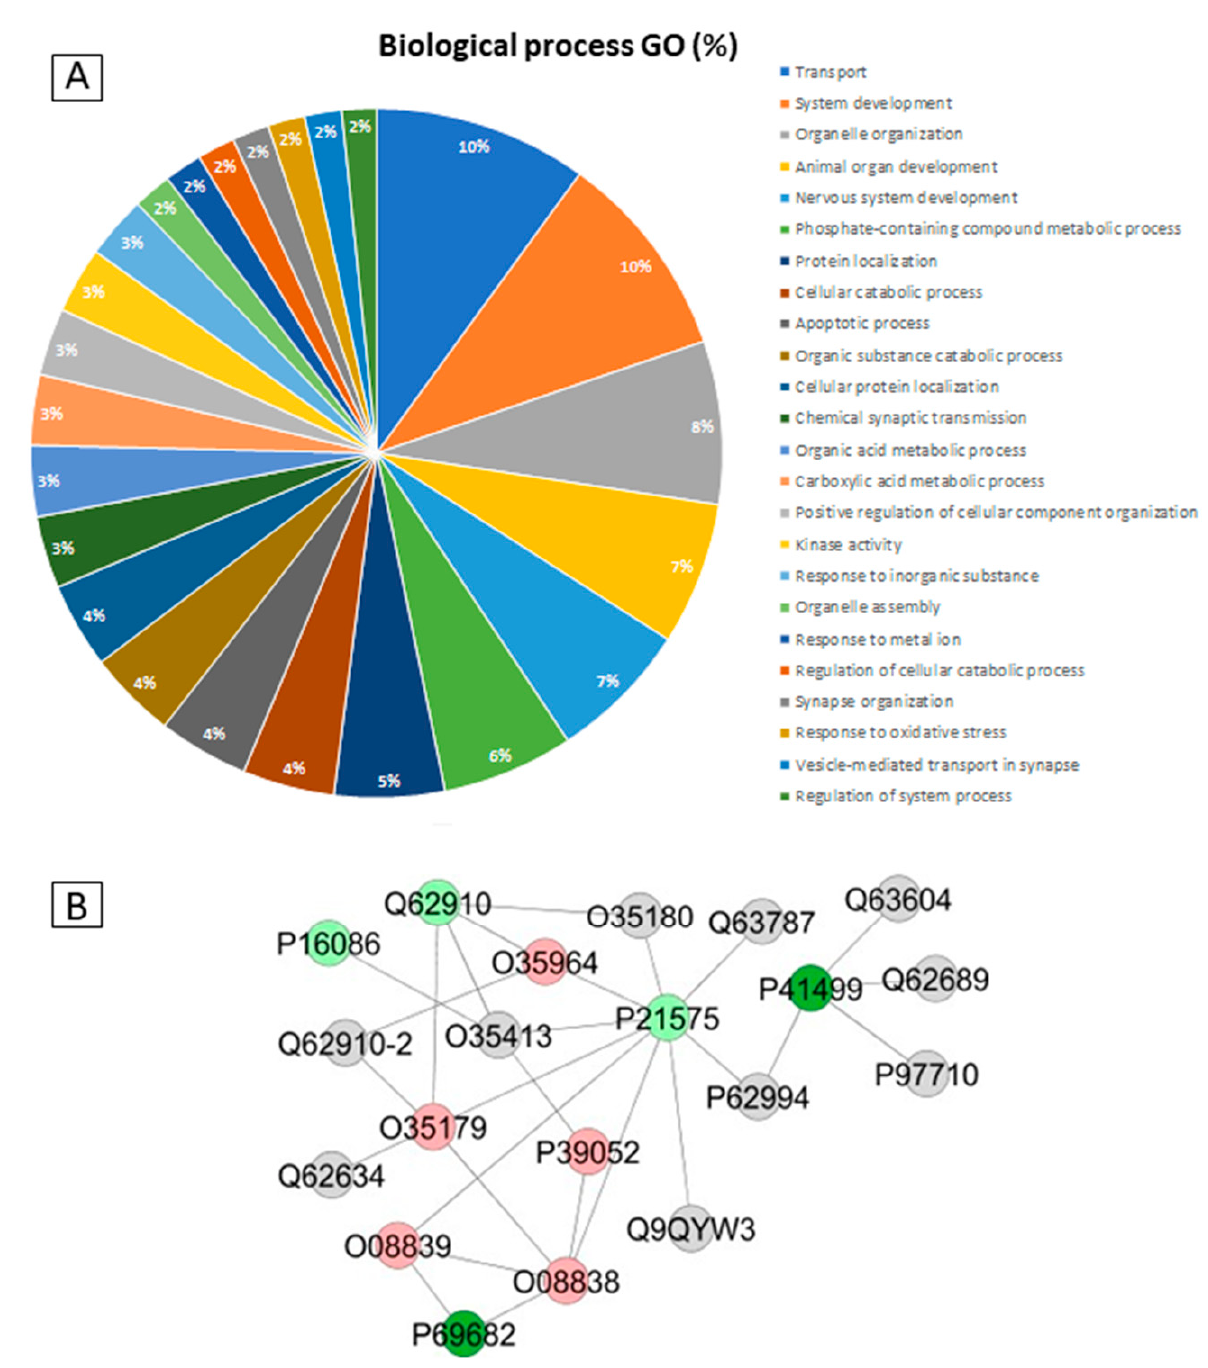
Figure 3. Functional distribution of proteins identified with differential expression in the cerebellums of adult rats between the MeHg group and the control group ( A ). Protein categories are based on the Gene Ontology (GO) of biological processes. ( B ) Protein–protein interaction network. Red and dark green colors indicate proteins found in the control and exposed groups, respectively; light green and pink colors indicate upregulated and downregulated proteins, respectively; gray nodes represent those proteins that were not identified in this study but which entered into interactions in the network.